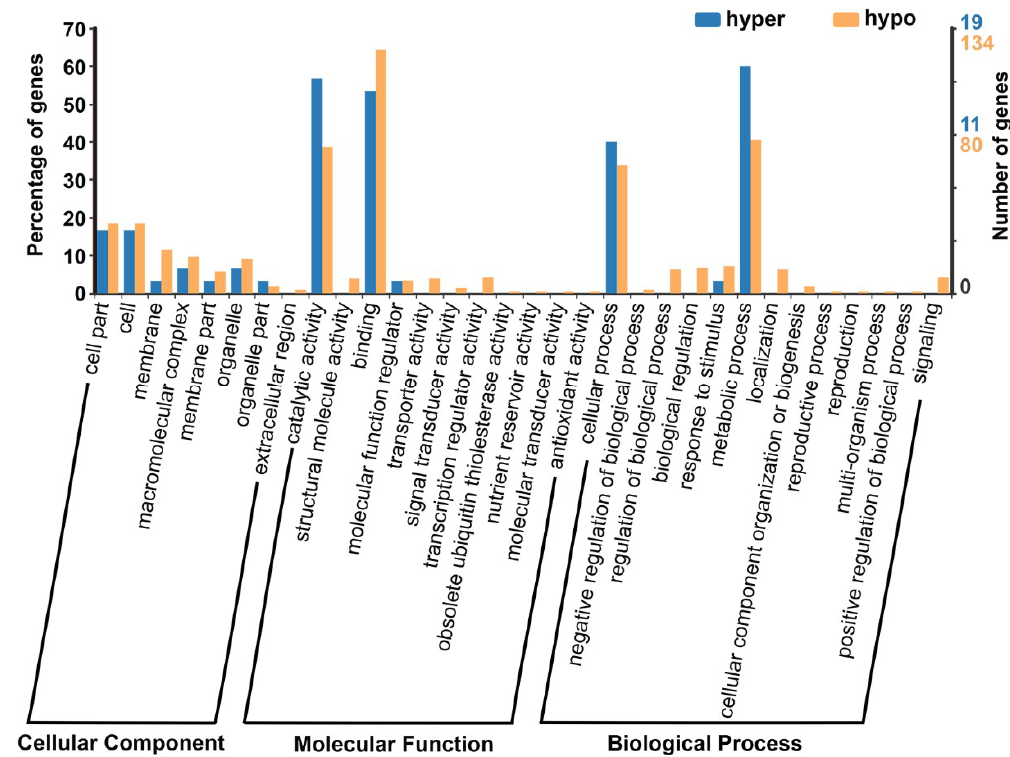
Figure 6. GO analysis of all DMGs. Hypo: hypomethylated; hyper: hypermethylated.